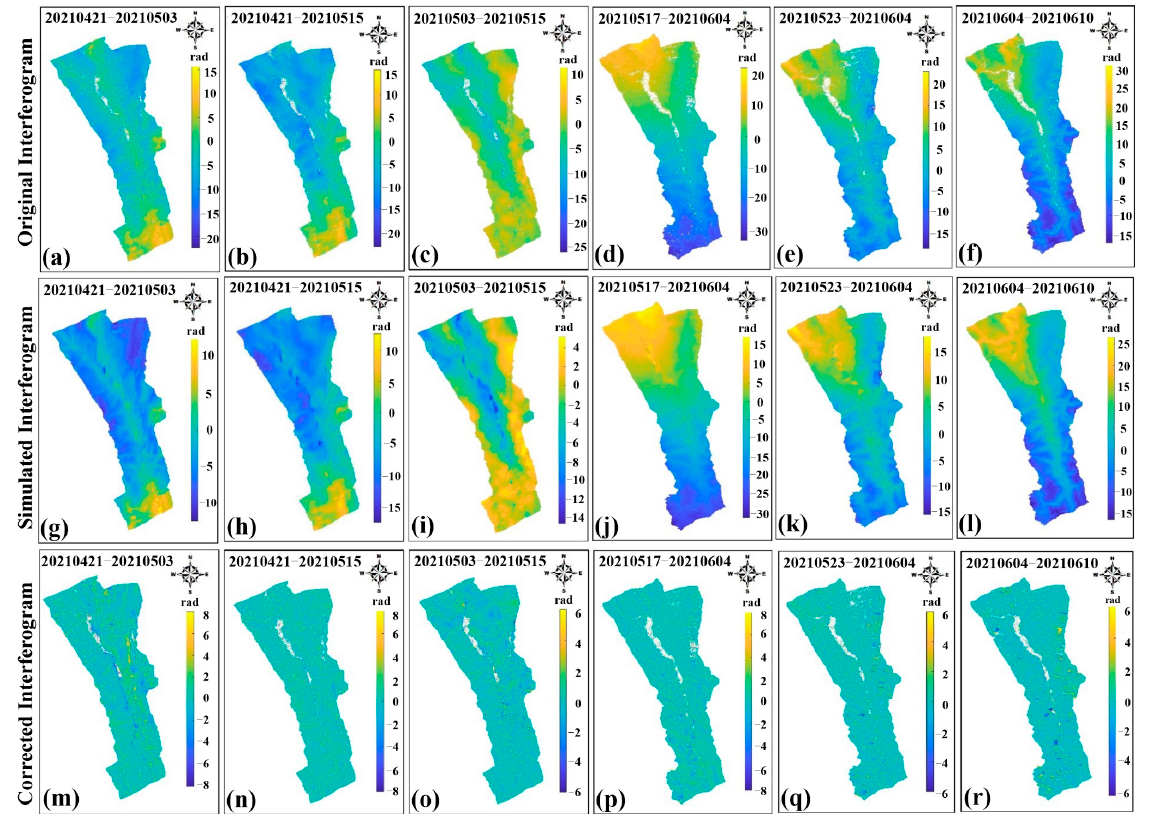
Figure 3. ( a – f ) Original interferometric pair; ( g – l ) simulated phase interferometric pair by MLP neural network model; ( m – r ) interferometric pairs after atmospheric correction by MLP neural network model.